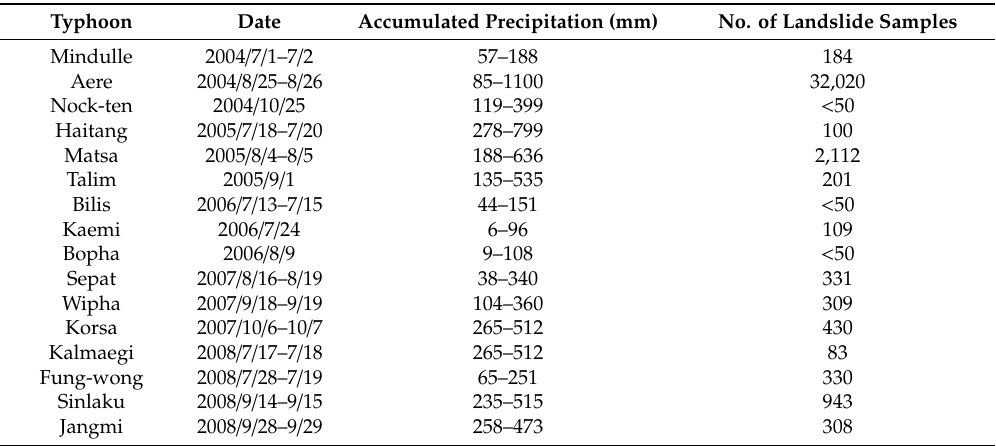
Table 1. Typhoon events and the number of landslide samples used from the landslide inventory.